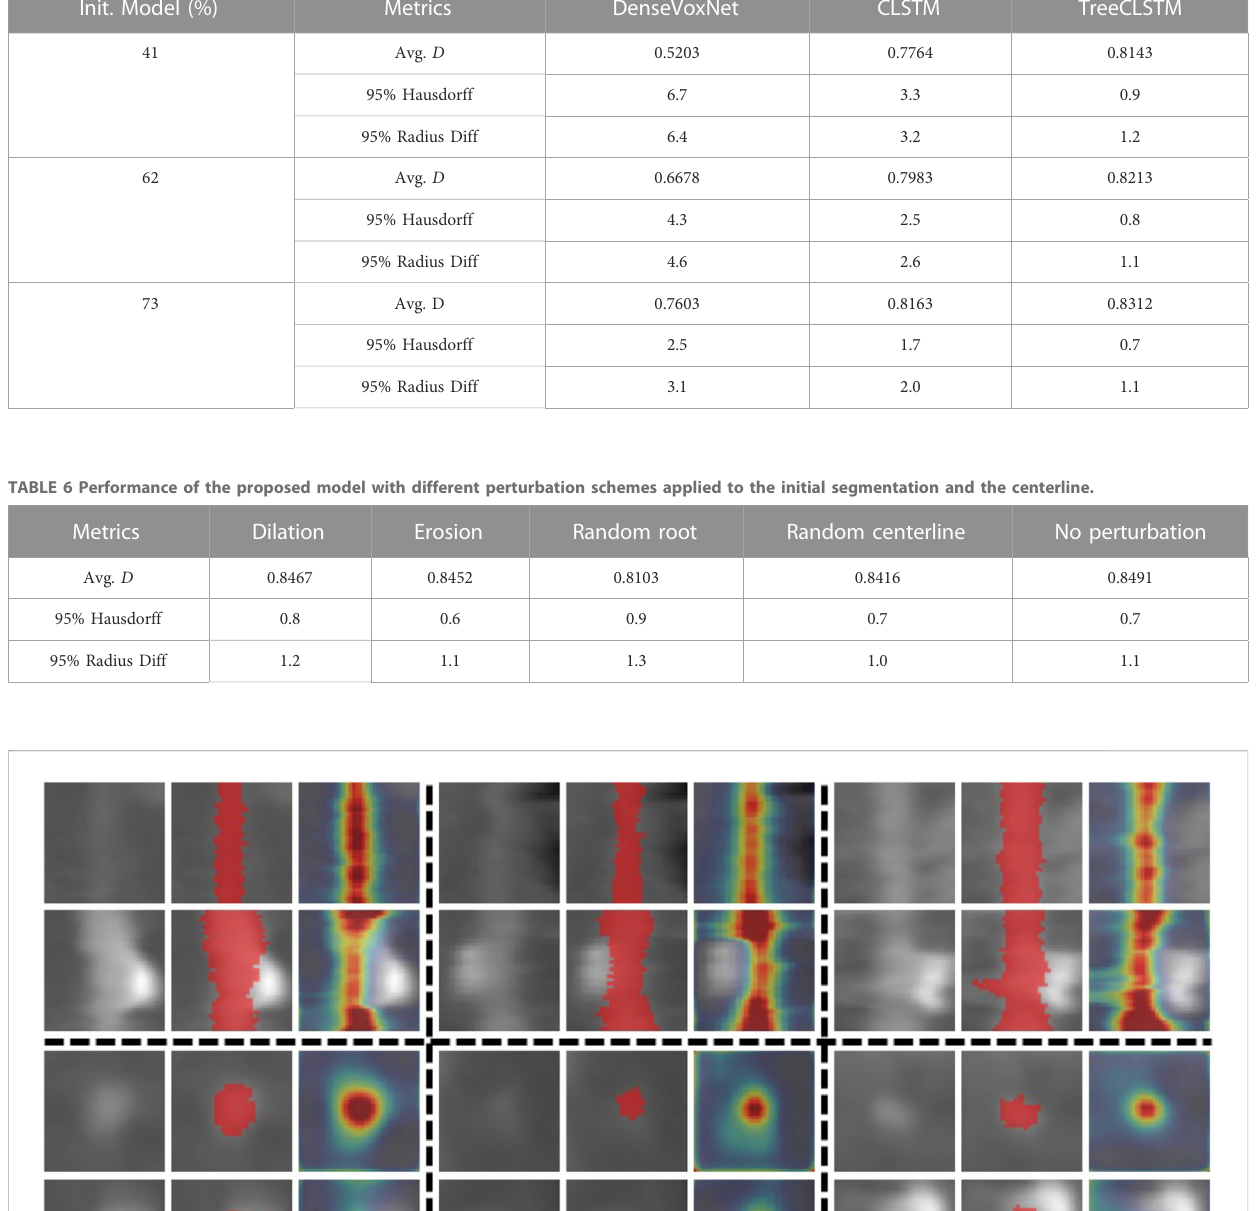
TABLE 5 Performance comparison of three different initial segmentation models. Init. Model (%)